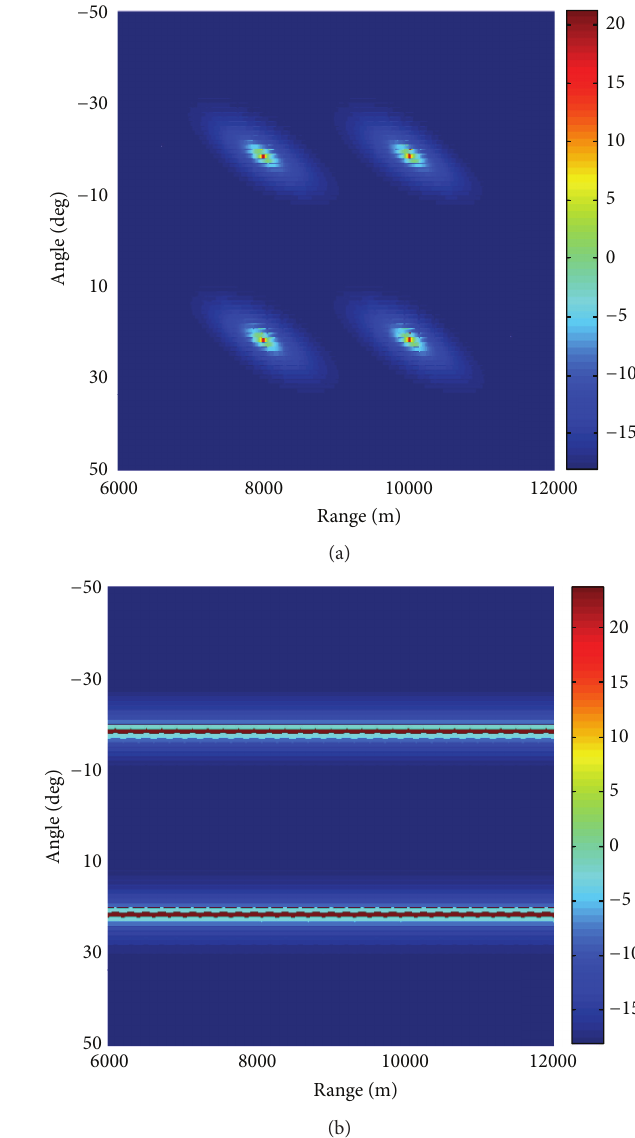
Figure4:Powerspectra:(a)FDAMIMOradarand(b)conventional MIMO